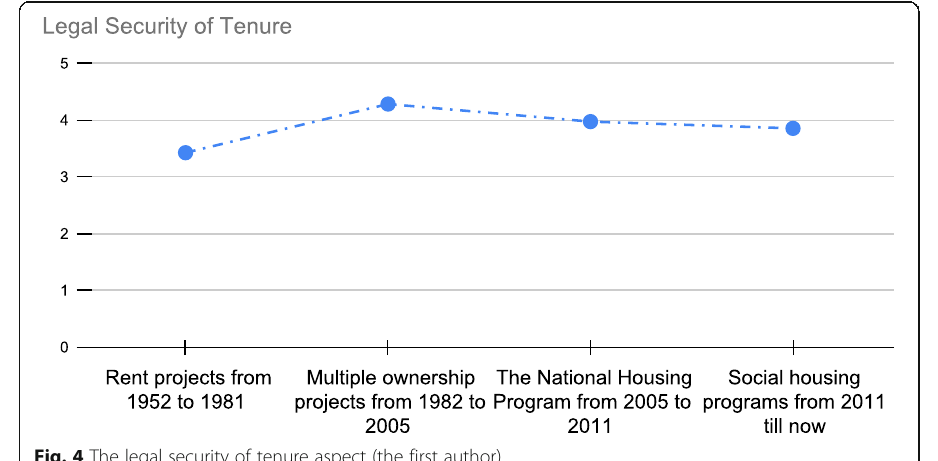
Fig. 4 The legal security of tenure aspect (the first